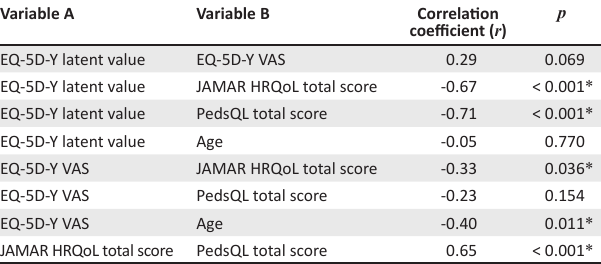
TABLE 2c: Correlations between outcome measures for females. n = 40.